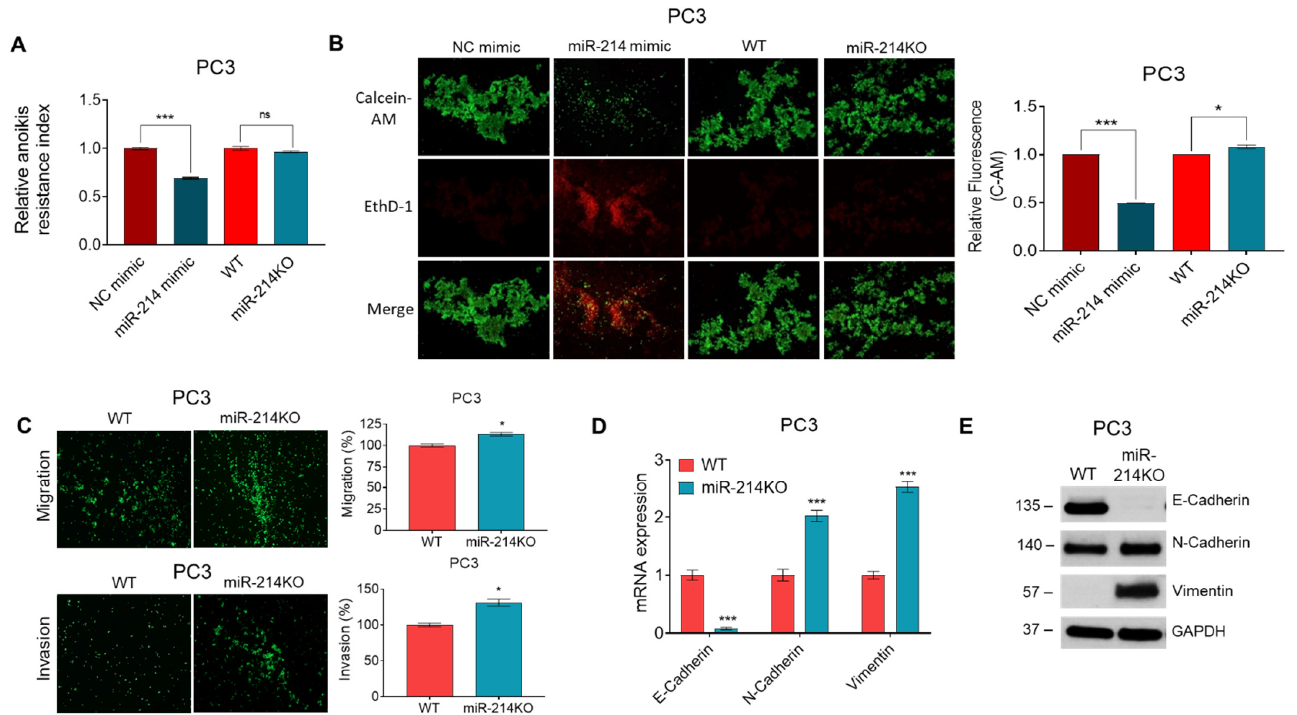
Figure 2. Inhibition of miR-214 expression increases PC3 cell anoikis resistance, migration, and invasion. PC3 cells transfected with miR-214 mimic or CRISPR/Cas9-deleted miR-214 were inoculated in a Poly-HEMA coated 24-well plate for 48 h. ( A ) Quantification of anoikis after 48 h using MTT assay of miR-214 mimic compared to NC mimic and miR-214KO normalized to WT PC3 cells. ( B ) Images and quantification of relative fluorescent staining of living cells (C-AM) and dead cells (EthD-1). ( C ) Transwell migration and invasion assays were used to determine the effect of miR-214 downregulation on PC3 cell migration and invasion (left panel). The percent of miR-214KO cells that migrated or invaded through the membrane was calculated with the formula (miR-214KO/WT) × 100 compared to WT (right panel). ( D ) Changes in E-Cadherin, N-Cadherin, and Vimentin mRNA in miR214-deleted PC3 cells normalized to its WT control were analyzed by qRT-PCR. ( E ) Western blot analysis revealed that knockdown of miR-214 significantly decreased E-Cadherin and increased N-Cadherin and Vimentin expression in PC3 cells. Original blots see Supplementary File S2. GAPDH was used as the loading control. One-way ANOVA and two-way ANOVA followed by Tukey’s and Š í d á k’s multiple comparisons test were used to determine statistical significance for anoikis and qRT-PCR assay, respectively. Data are presented as mean ± SEM, * p < 0.05, *** p < 0.0005, NS = not